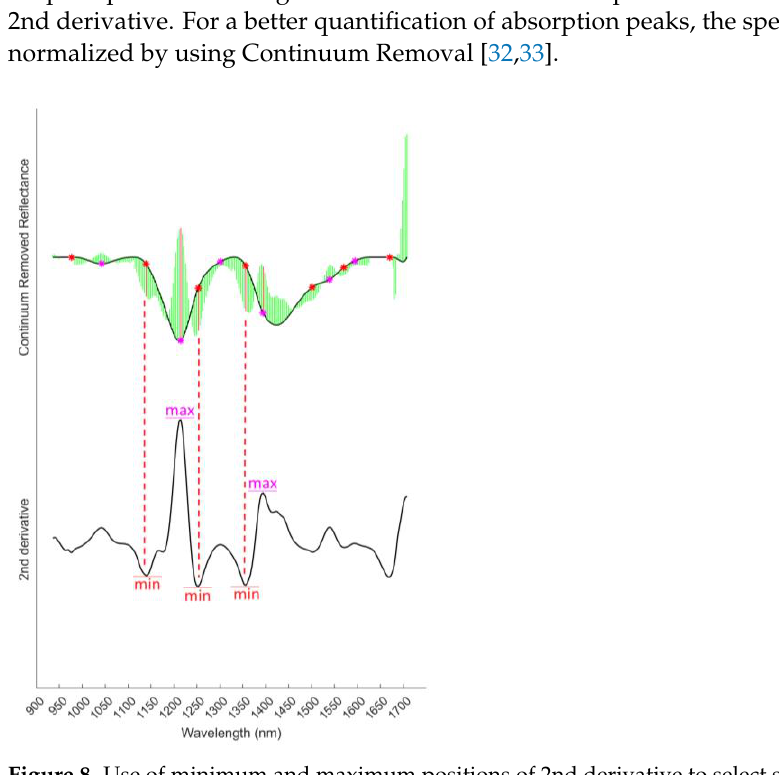
Figure 8. Use of minimum and maximum positions of 2nd derivative to select significant parameters for shape description. Parameters are the location (min/max), the curvature values at these locations (red lines) and the direction of curvature value (up for convex and down for concave behavior) [31]. In Figure 9, the normalized spectra and the calculated curvatures for polystyrene (PS) and polypropylene (PP) are shown, which express a clear difference in the spectral foot- print of both materials. The length of the green and red lines indicates the strength of the